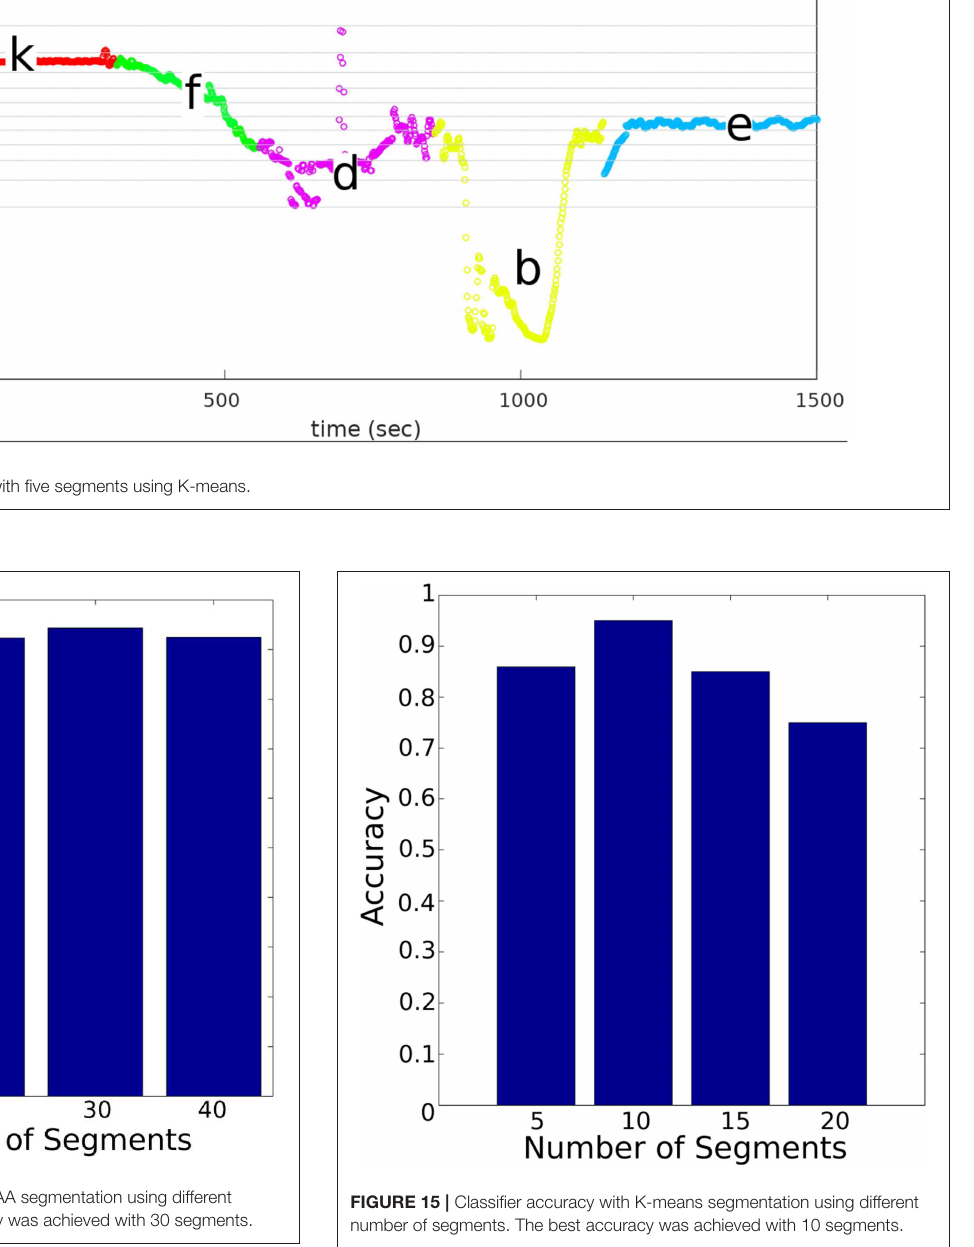
and Lee (1991), where N symbols is the number of symbols, K proposed approach with K-means occurs when the N symbols is the number of original dimensions before the PCA, M is is 12, and M is 10; however, the time complexity of the K- the number of segments, N sample is the number of samples means is quadratic of the N samples , which was on average 1500 within the time-series and D is the number of selected features samples. Henceforth, the K-means is the bottleneck for this (selected dimensions based on the PCA). For the proposed case, which explains the long execution time to recognize approach with PAA, the worst case scenario occurs when the the CS in comparison with PAA. In comparison with the N symbols is 12, and M is 30. In this case, the complexity of method introduced in Jamali et al. (2014), the complexity the HMM is the bottleneck; hence, the total complexity is of MML-GMM, that was used to cluster the Force/Torque O (2 K N data), was O ( M N samples D ). Nevertheless, the complexity samples D ). On the other hand, the worst case for the